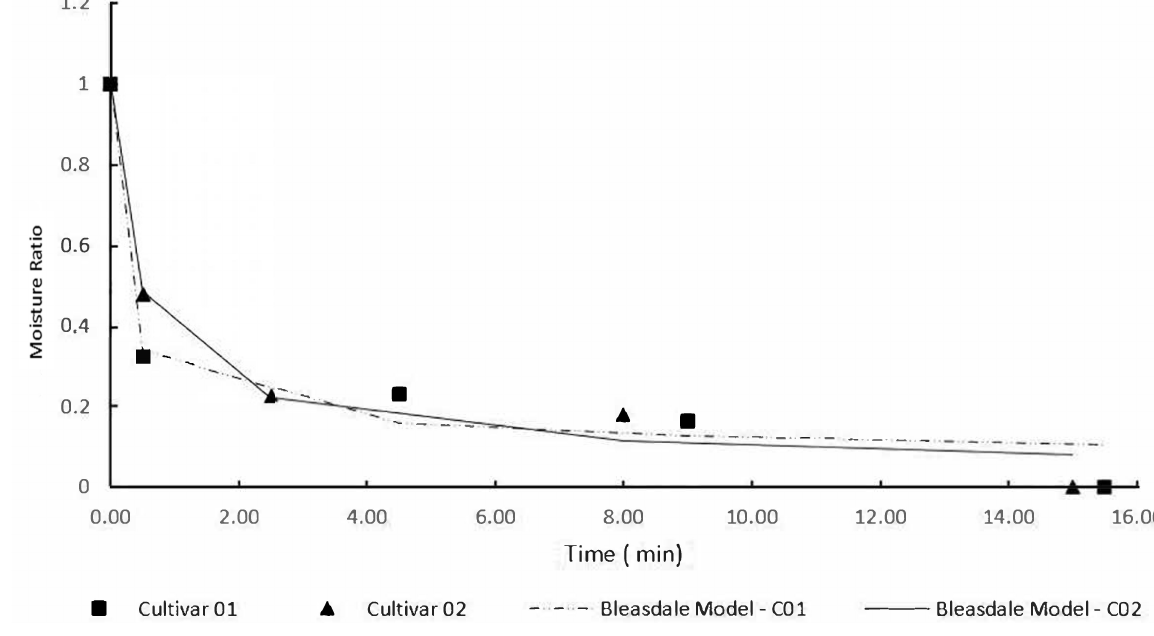
Figure 1. Reduction of water content during the